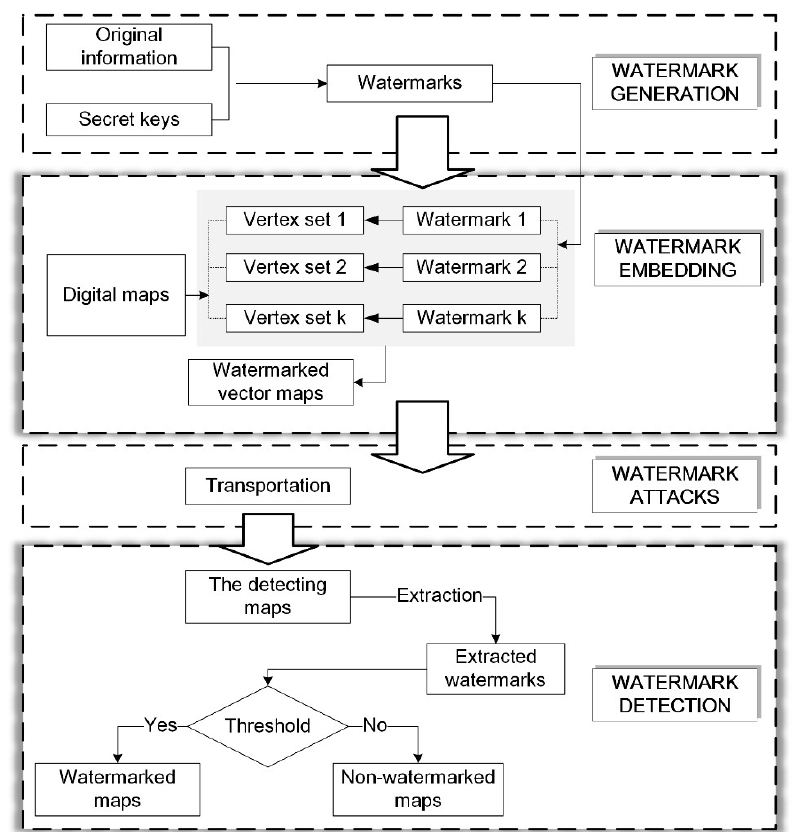
Figure 2. The proposed multiple watermarking algorithm.